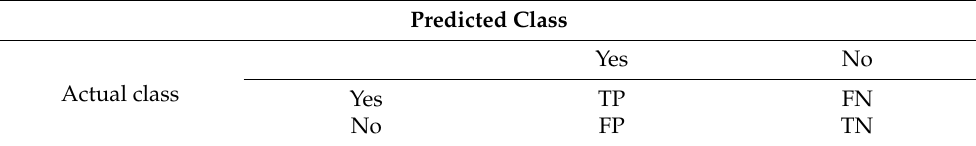
Figure 2. Some of the analyzed malware samples (different types, variants, and families). Table 4. Confusion